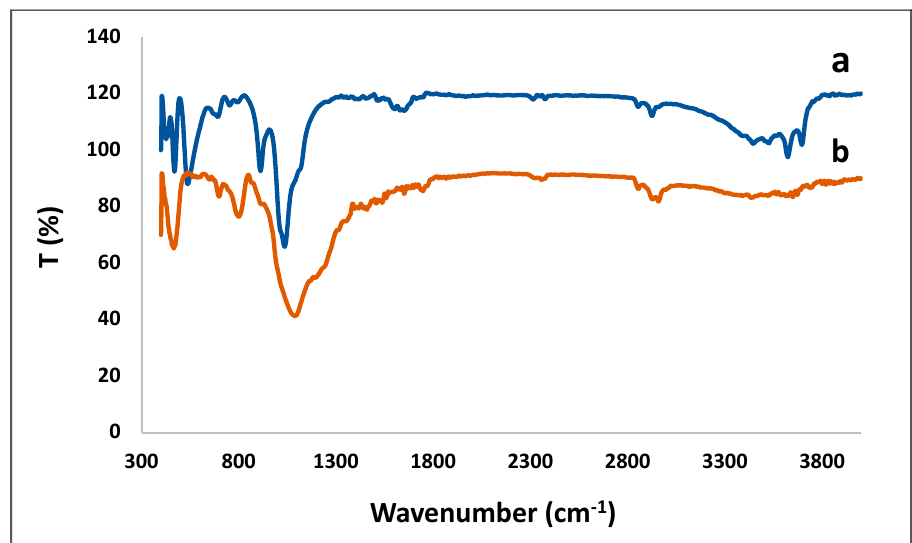
Figure 1. FT-IR spectra of: ( a ) HNTs and ( b ) acid treatment